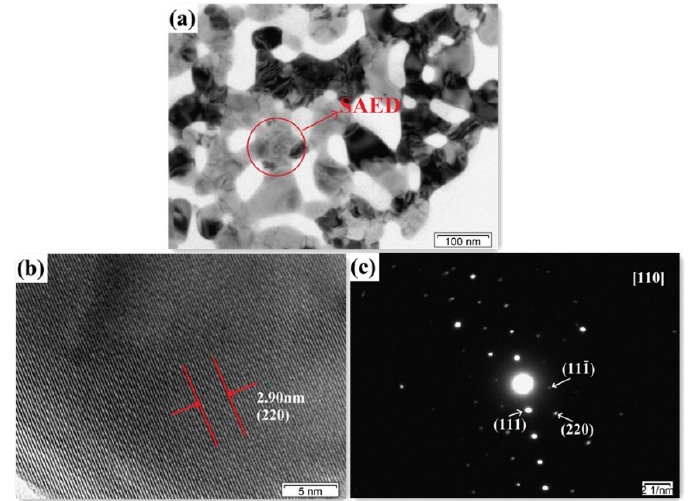
Figure 3. ( a ) Transmission electron microscope (TEM ) image of MCO-600; ( b ) High resolution transmission electron microscope (HRTEM) image of MCO-600; ( c ) Selected area electron diffraction (SAED) pattern of MCO-600.